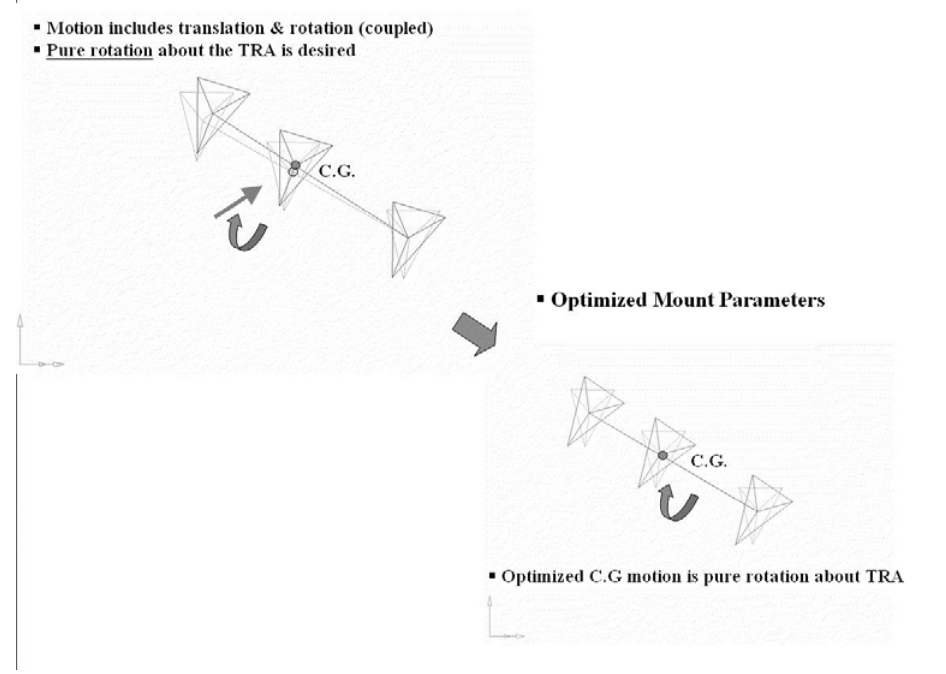
Fig. 6. The optimal CG motion due to unit torque about the crank-shaft axis, compared with that of the baseline configuration, is shown here. ( λ > μ ). Then according to ( μ, λ ) strategy, only the best performing μ offsprings are retained as parents for the